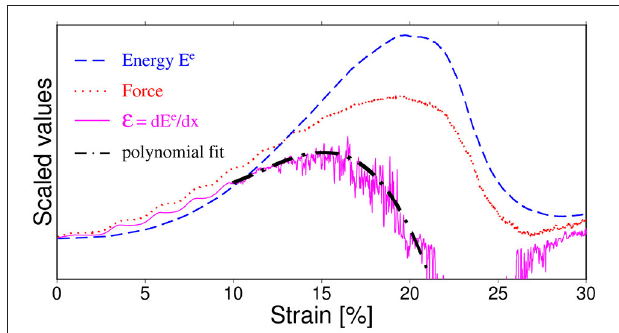
FIGURE 4 | An example of simulated loading curves and the illustration of the procedure of estimation of maxima of F ( x ) and E ( x ) curves by means of a polynomial approximation. The maximum of E ( x ) is found by fitting a 3rd order polynomial to an appropriate curve around its noisy maximum. The same procedure was used for getting x c from F ( x